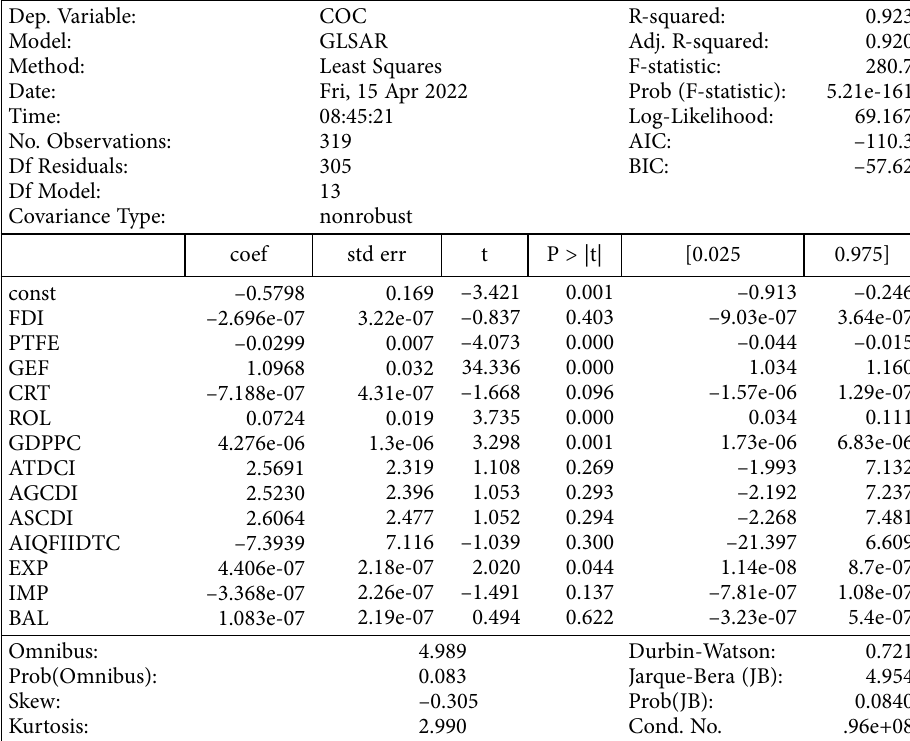
Table 9. GLSAR regression results – Part 2 (source: own processing using Python 3.0